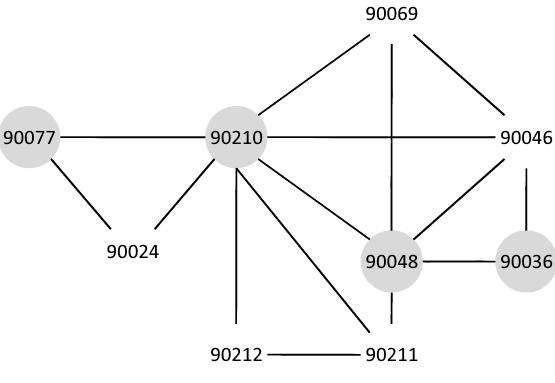
Figure 14. General ZIP code graph.